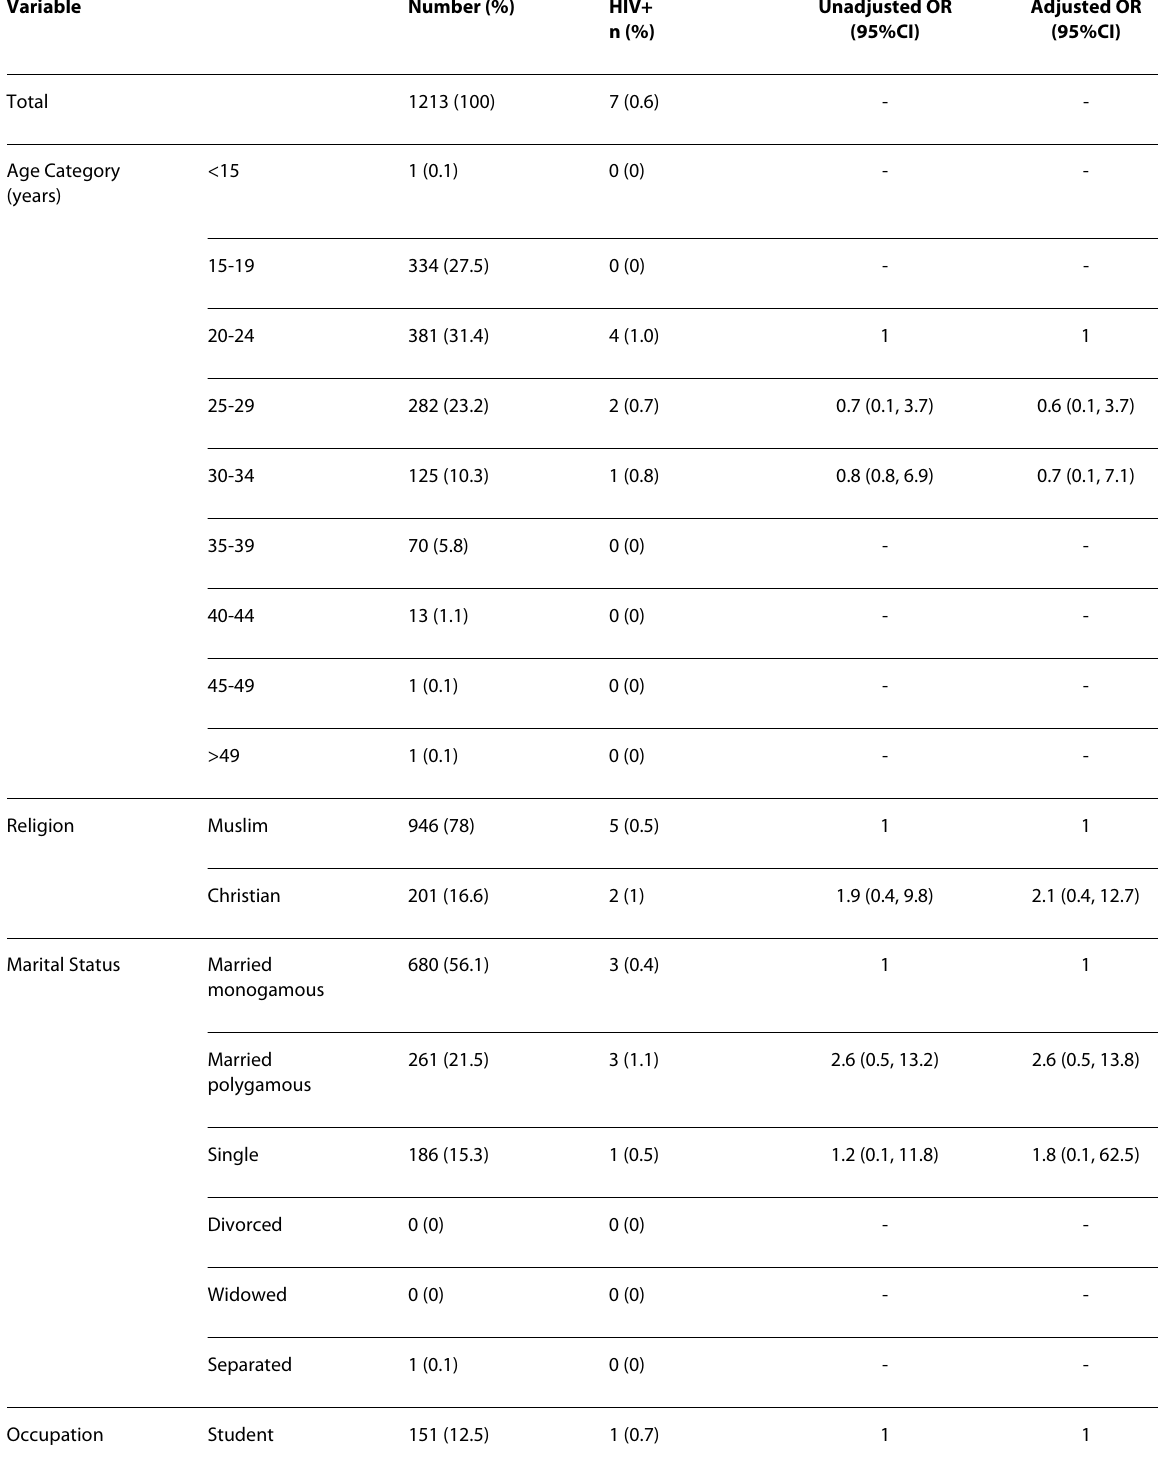
Table 1: Antenatal population: Characteristics and unadjusted and adjusted OR for HIV